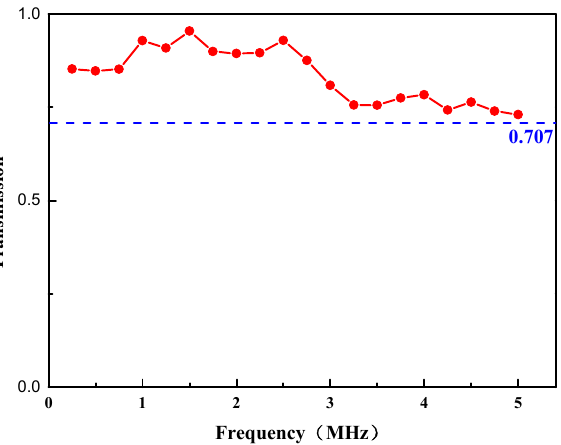
Figure 8. Frequency response of the transmission coefficients of the matching layer.